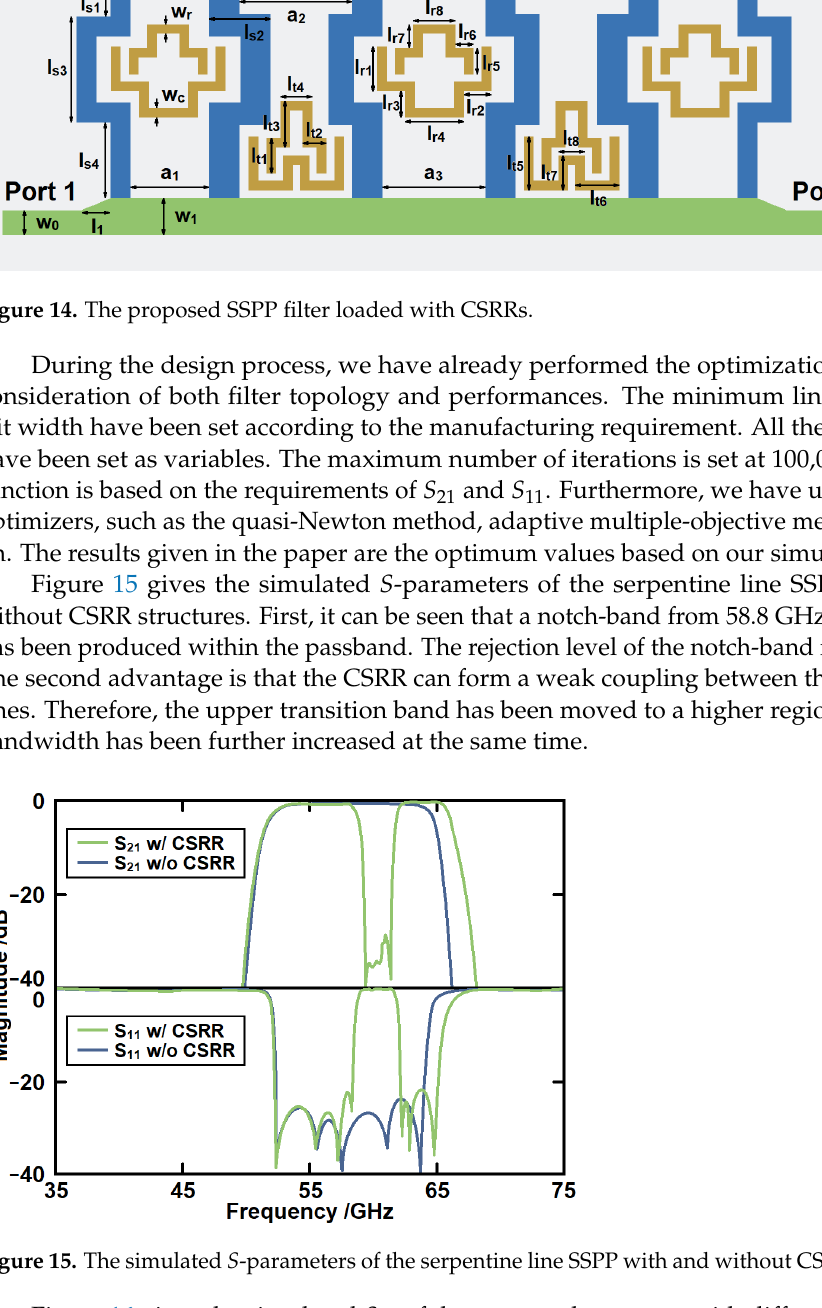
Figure 13. The component values with respect to dimensions ( a ) C , ( b ) L , and ( c ) C m .